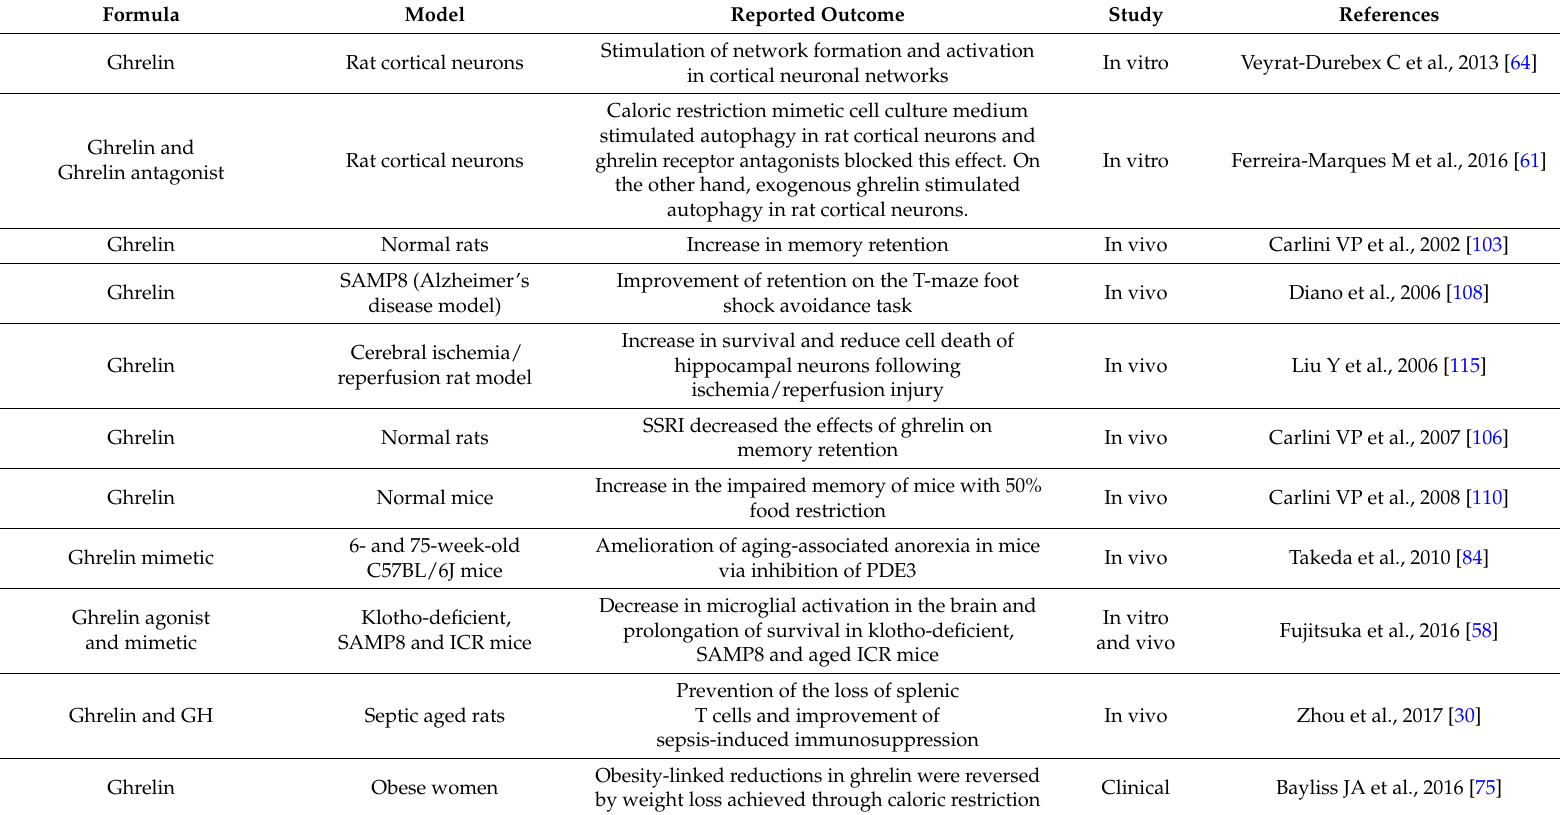
Table 1. Ghrelin and